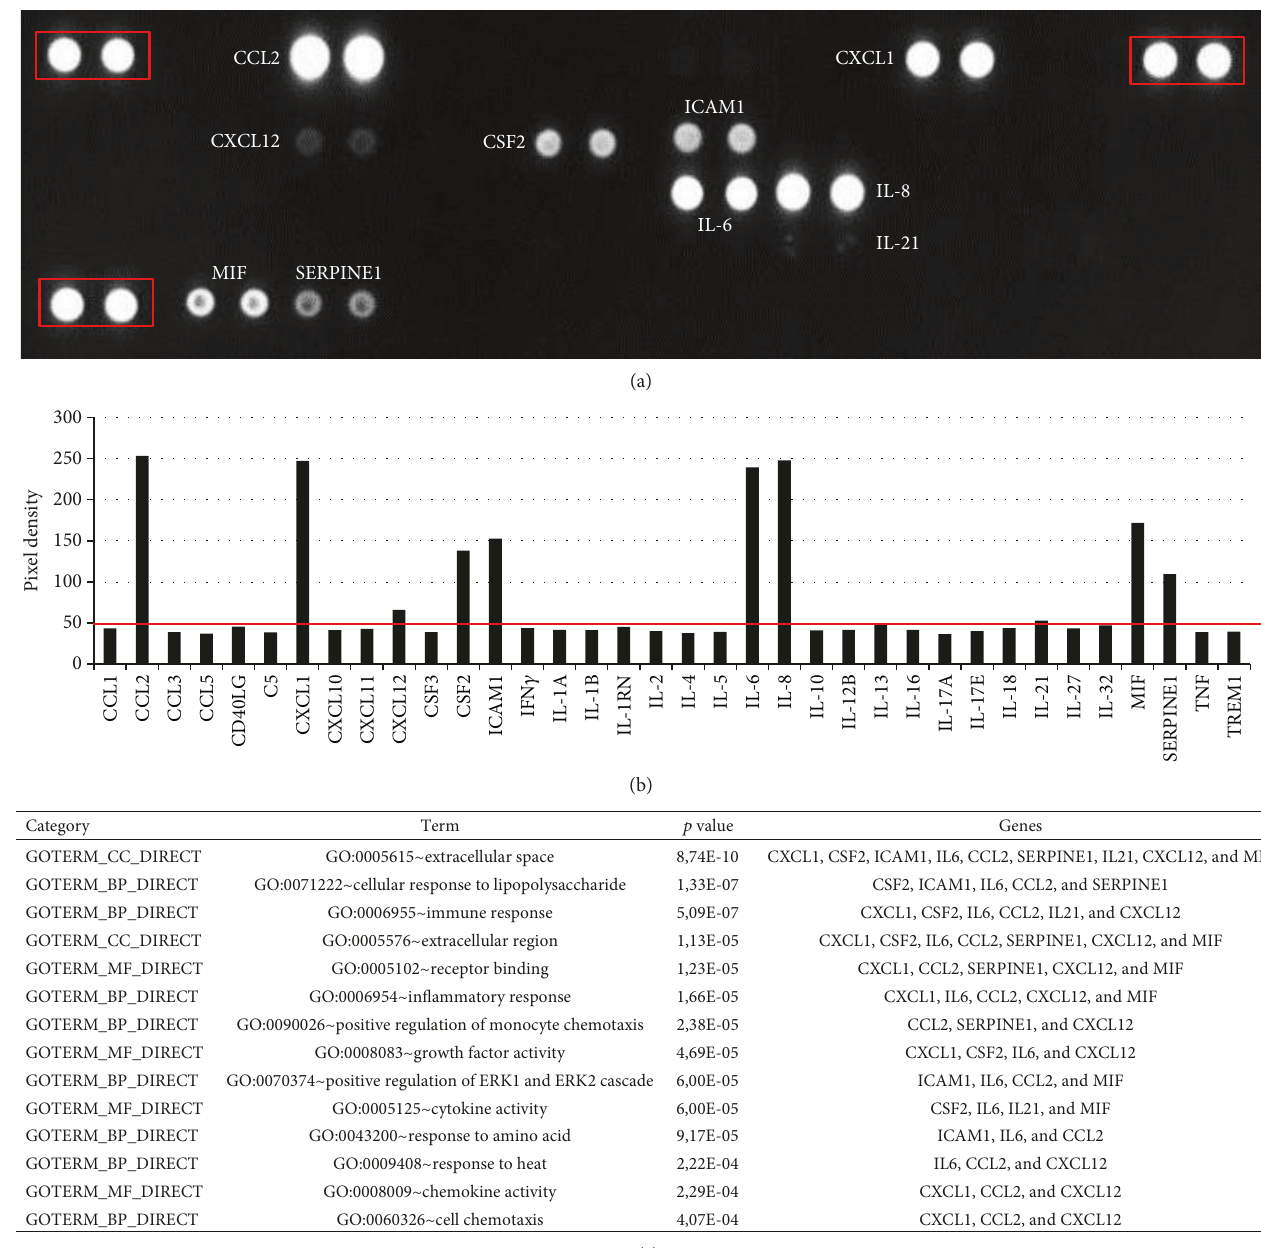
Figure 4: Secretome analysis of AF-MSCs. The cytokines CCL2, CXCL1, CXCL12, CSF2, ICAM, IL-6, IL-8, IL-21, MIF, and SERPINE1 were detected by protein arrays in cell culture supernatant from AF-MSCs. A membrane with spotted antibodies was used for detection. The three red-boxed spot pairs in the corners represent protein array quality controls (a). Densitometric analysis revealed speci fi c pixel densities; the pixel density of 50 represents the threshold (red line) (b). Gene ontology analysis of secreted cytokines revealed the shown top 14 results with p values below 0.0005